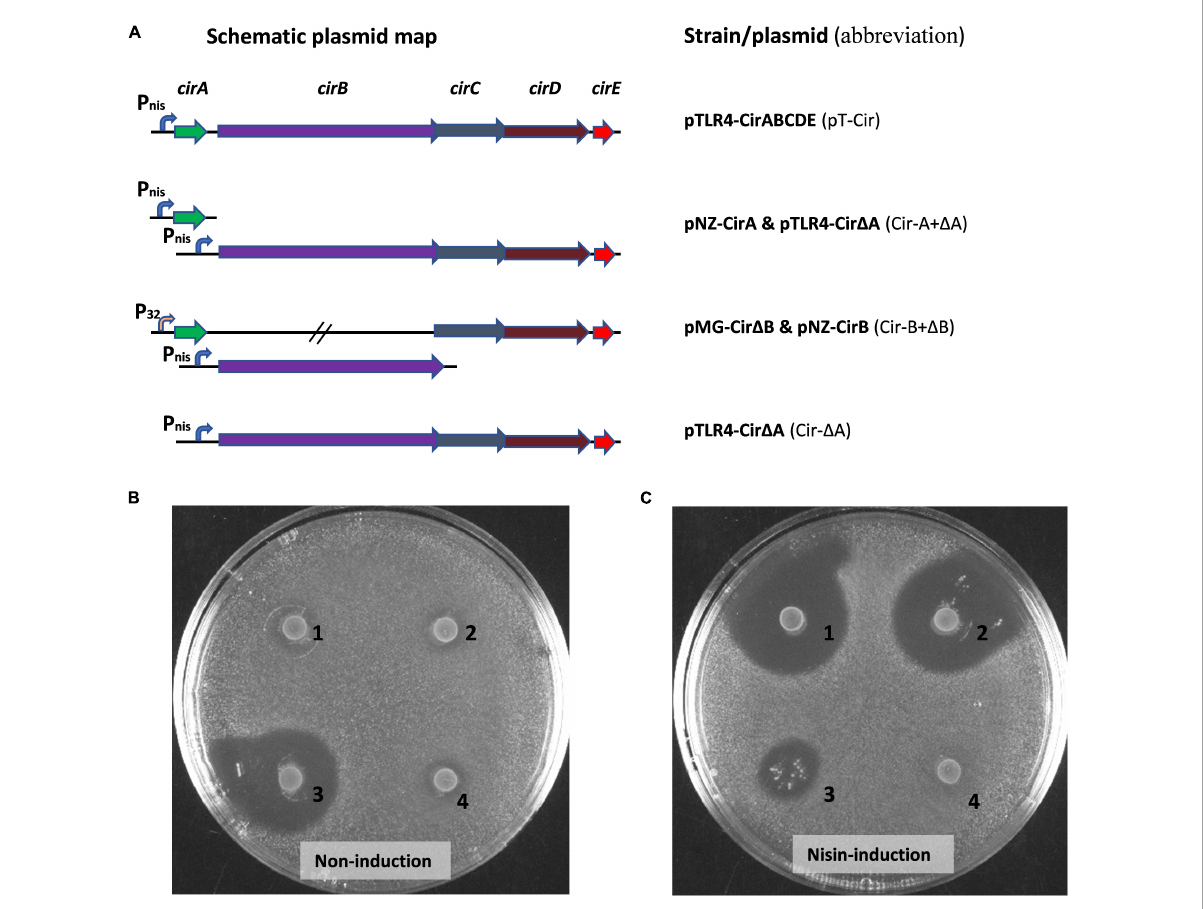
FIGURE2 Heterologous production of circularin A in Lactococcus lactis NZ9000. (A) Construct design of the circularin A gene cluster in Lactococcus lactis NZ9000 and antimicrobial production of circularin A under various conditions: (B) non-induction, and (C) nisin-induction. (1) pTLR4-CirABCDE; (2) pNZ-CirA and pTLR4-Cir (cid:49) A; (3) pMG-Cir (cid:49) B and pNZ-CirB; (4) pTLR4-Cir (cid:49) A. Their abbreviations are shown between brackets. Both the pNZ plasmid and the pTLR plasmid contain a nisin inducible promoter P nis , while pMG plasmid contains a constitutive promoter P 32 . The indicator strain: Lactobacillus sake ATCC